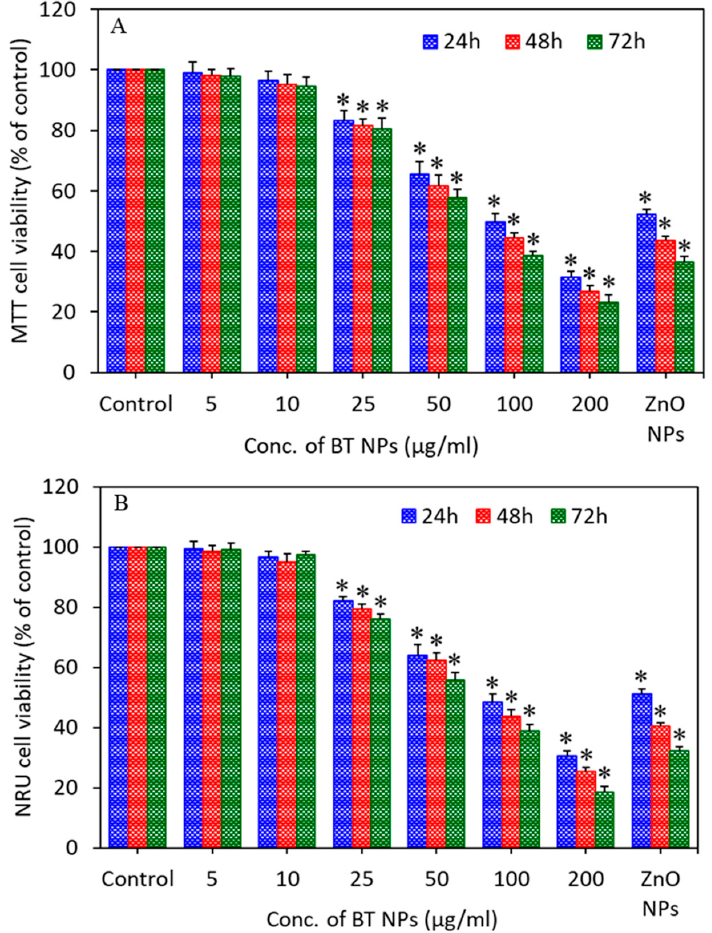
Figure 3. Cell viability of A549 cells exposed for 24, 48, and 72 h to di ff erent concentrations (5–200 µ g / mL) of BT NPs. ( A ) MTT cell viability. ( B ) NRU cell viability. ZnO NPs (25 µ g / mL for 24 h) were used as a positive control. Data are provided as mean ± SD of three independent experiments ( n = 3). * Indicates statistically significant di ff erence from the control group ( p < 0.05).